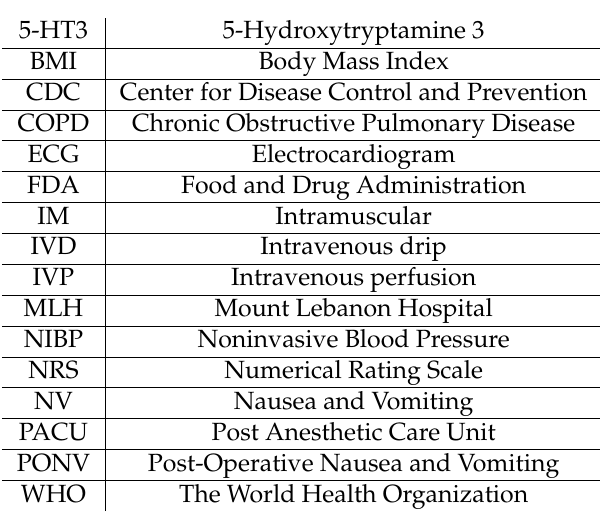
Table 2. List of